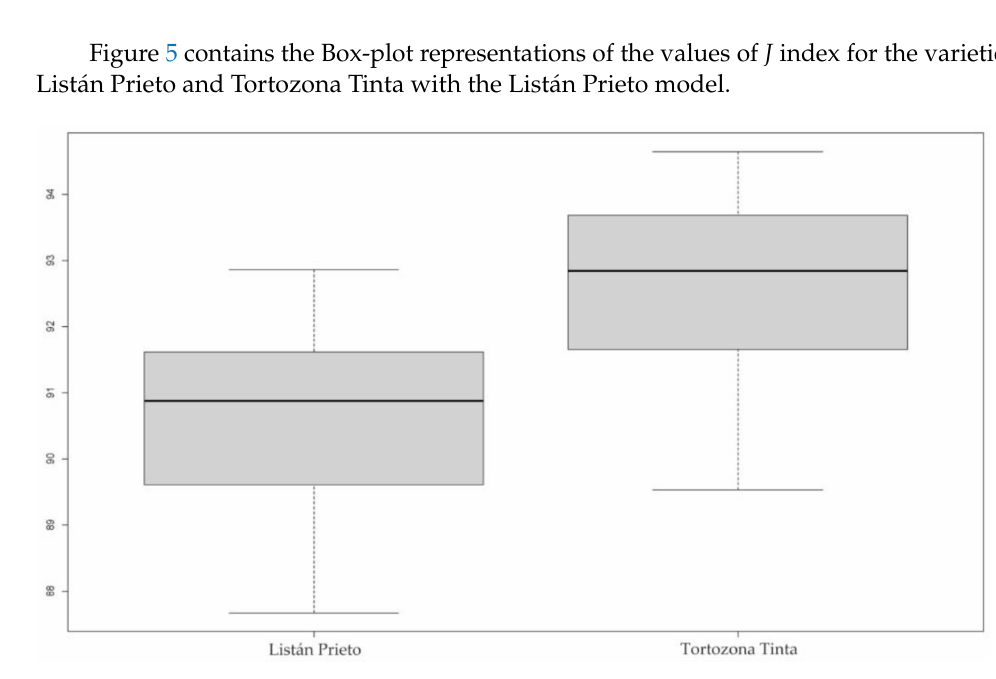
Figure 5. Box-plot representations showing the distribution of J index values in cultivars List á n Prieto and Tortozona Tinta with the List á n Prieto model.